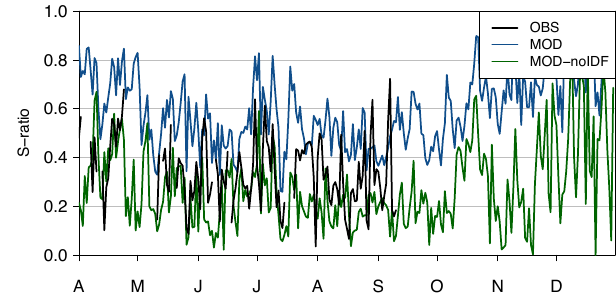
Figure 3. Observed and modeled (with – MOD case – and without – MOD-noIDF case – emissions over the Paris region) daily S ratio in